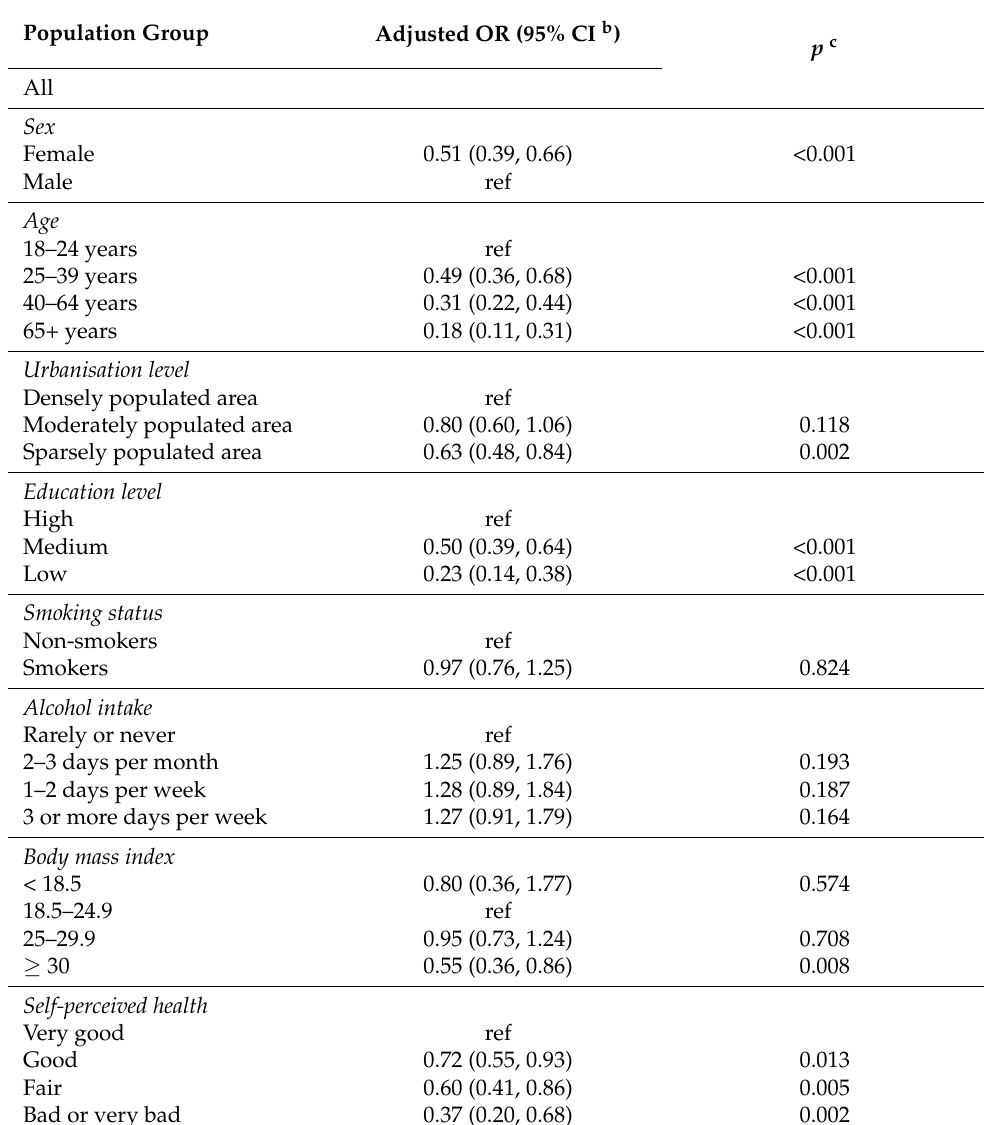
Table 3. Adjusted odds ratios (OR) of meeting the muscle-strengthening activity (MSA) guidelines a